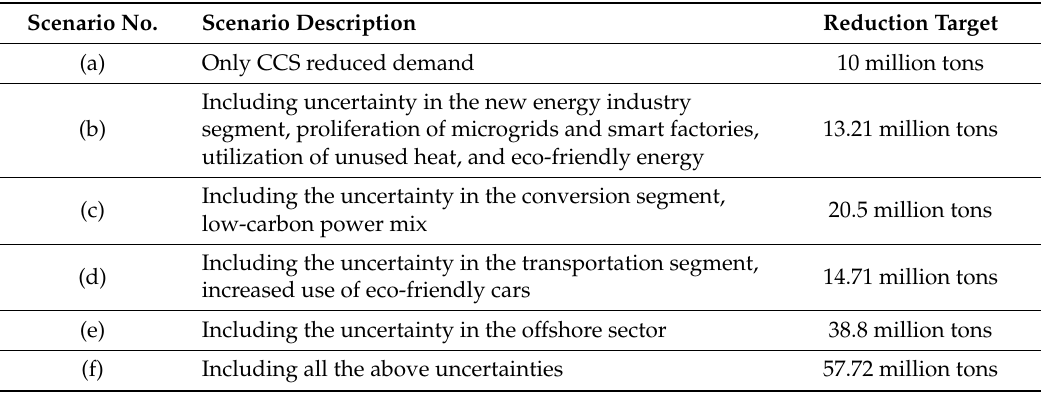
Table 5. Scenario description and reduction targets.